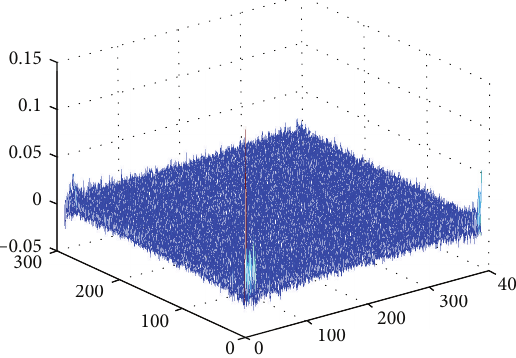
Figure 8: BLPOC function for PolyU palmprint database.